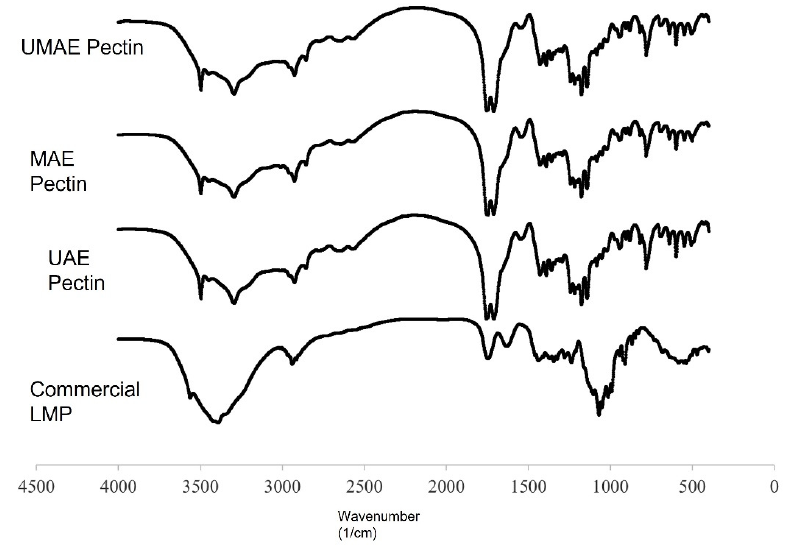
Figure 2. FT ‐ IR spectra of UAE, MAE, and UMAE pectin from tomato waste and commercial